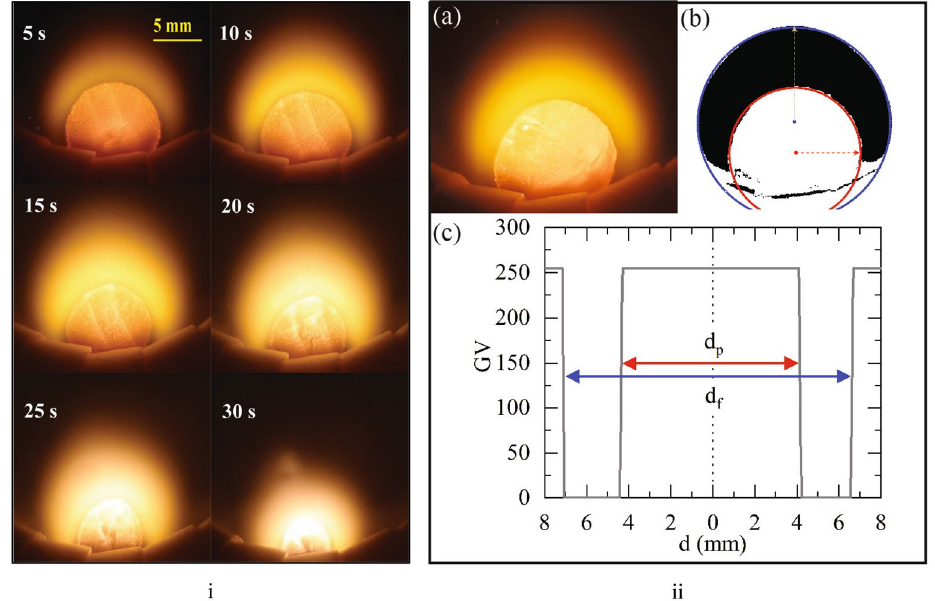
Figure 2. ( i ) Timelapse of a 10 mm diameter char particle subjected to reactive experiments of 1073 K and 100% O 2 ; ( ii-a ) Raw image, ( ii-b ) Processed image with circles fit to isolate the particle (red) and film (blue), ( ii-c ) measurements of particle diameter ( d p ) and film diameter ( d f ) in the processed image (Gray value (GV) profile across diameter